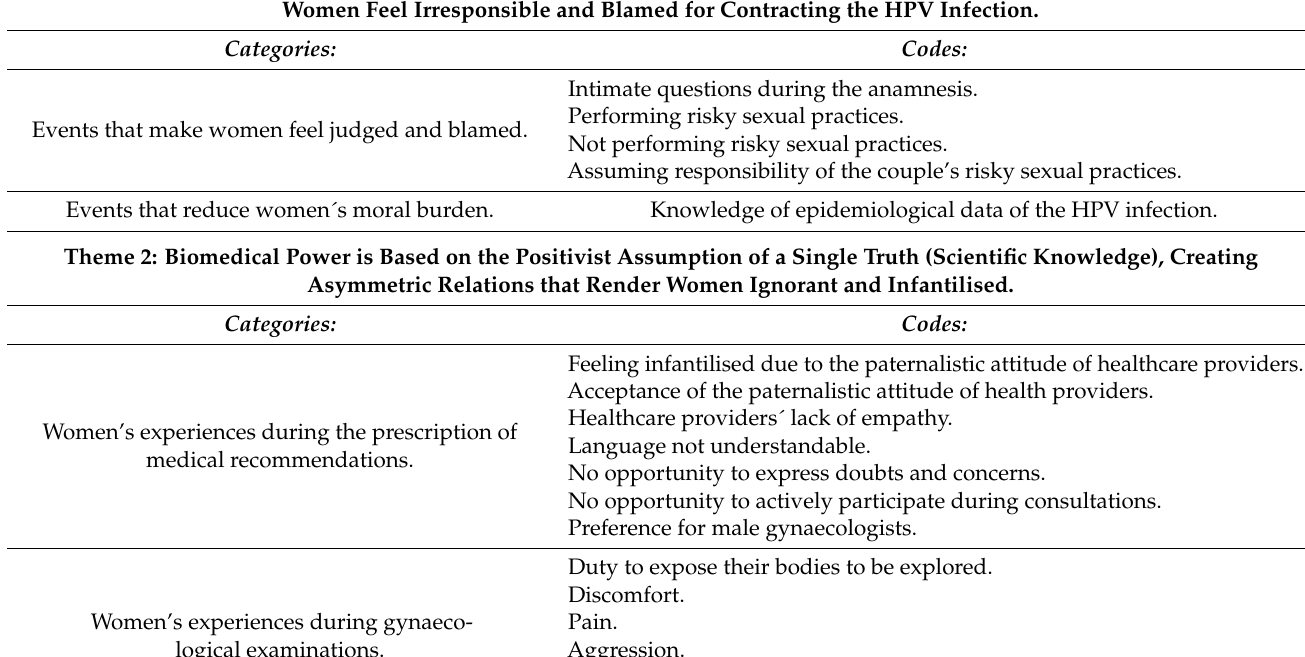
Table 2. Summary of